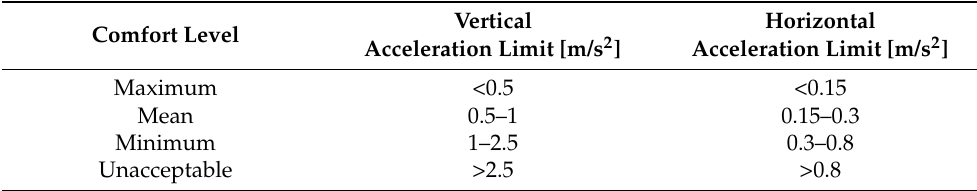
Table 5. Comfort levels and corresponding acceleration limits defined by S É TRA [28]. Comfort